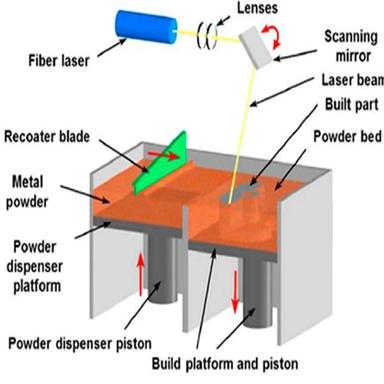
Schematic of LPBF process .